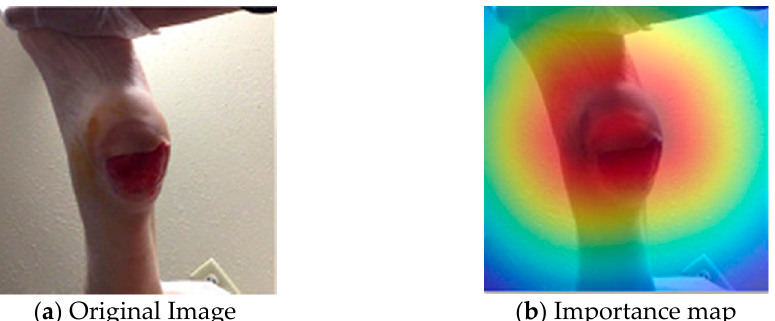
jury: 4.8%, surgical: 7.3% (Lymphovascular).